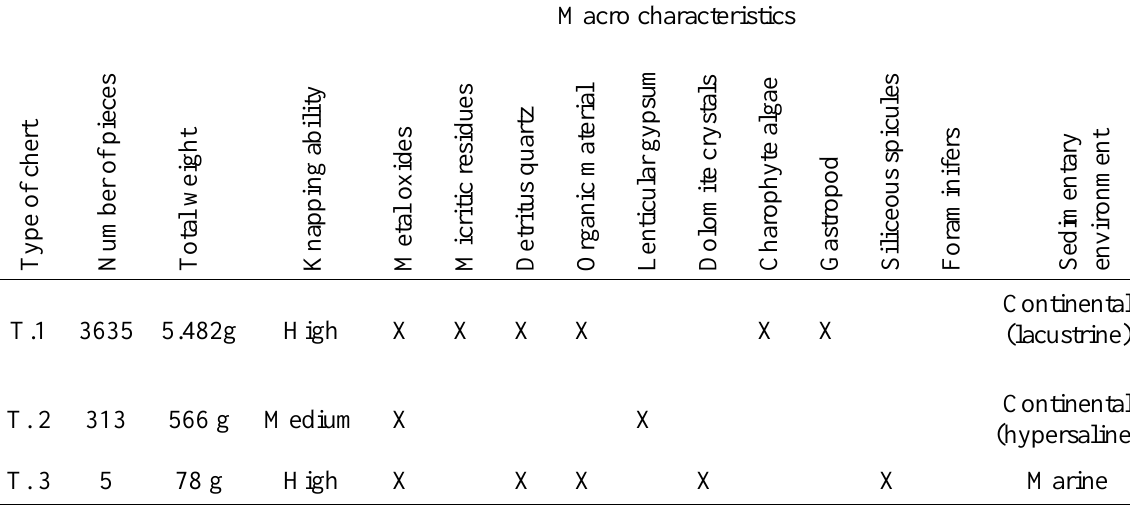
Table 3 – Main characteristics of each type of chert